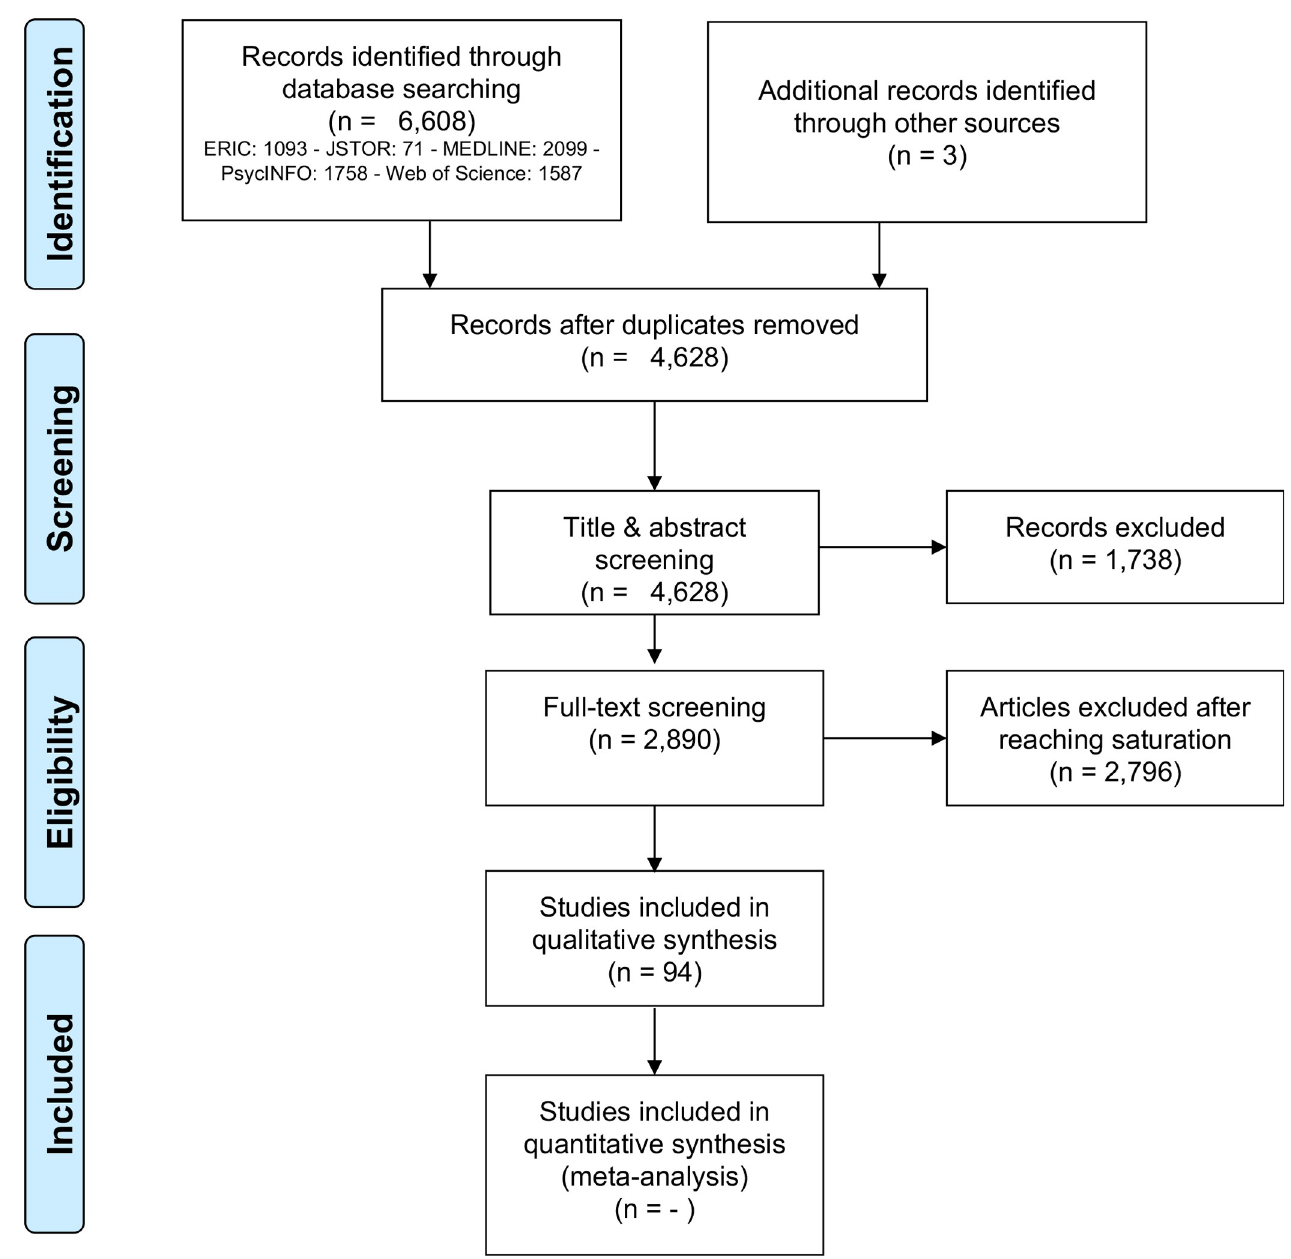
Fig 1. Overview of the screening process (PRISMA